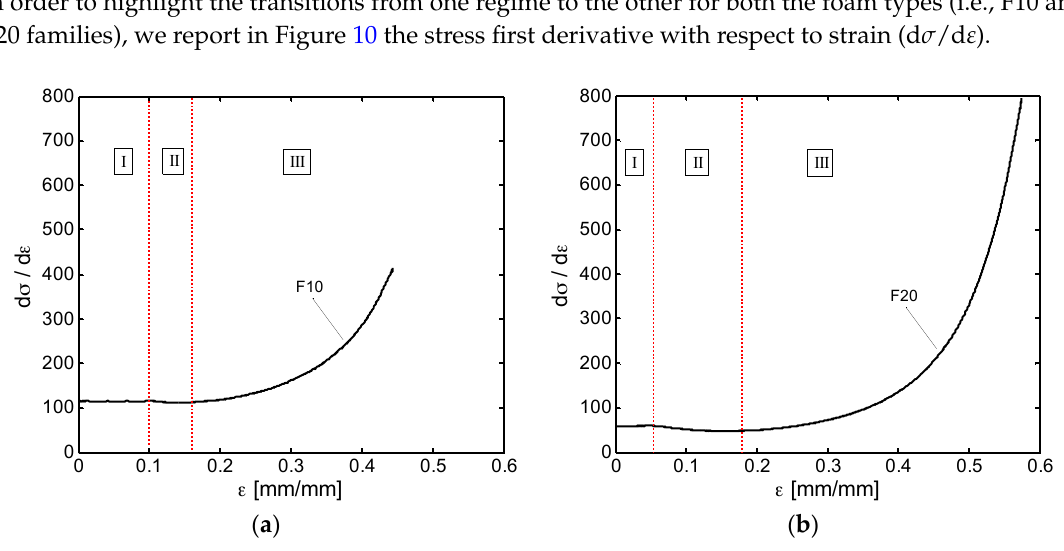
Figure 10. First stress derivative of a F10 ( a ); and F20 ( b ) foams pointing out the three foam transition regimes.